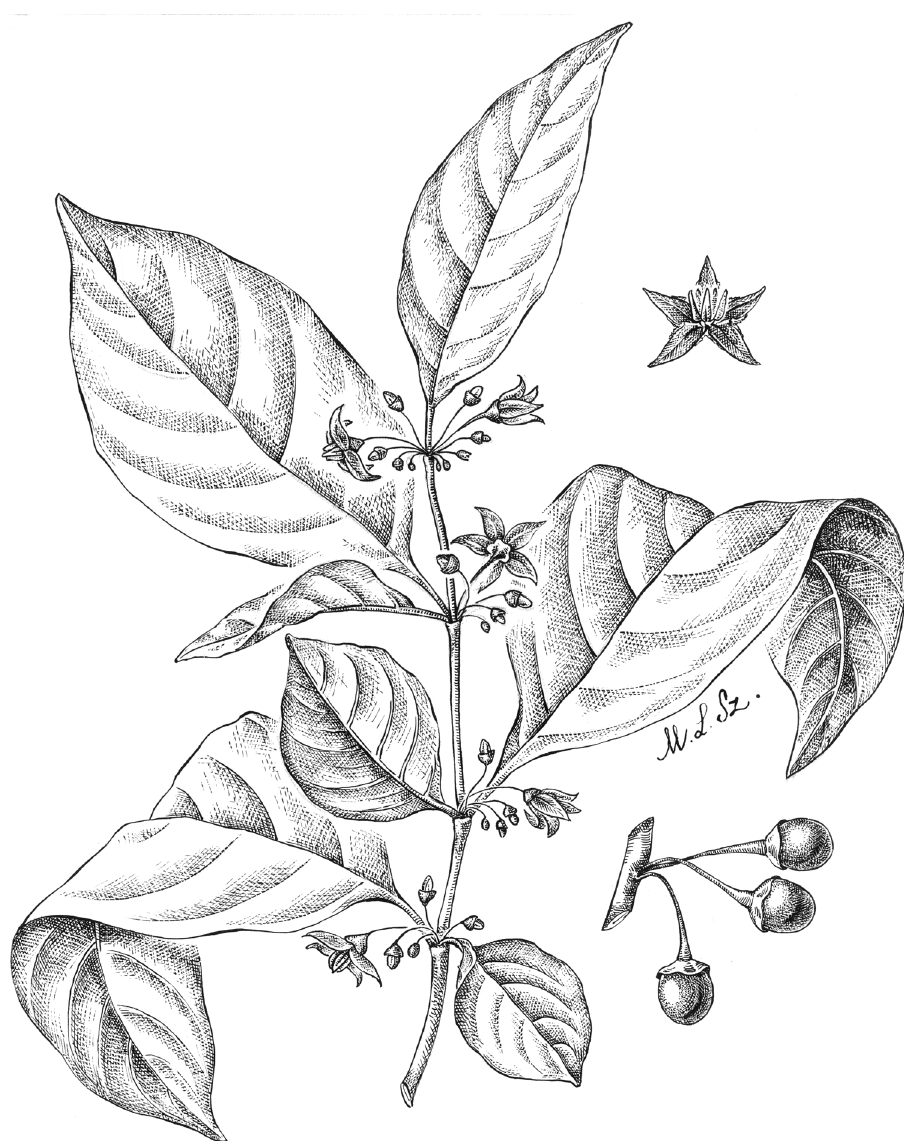
Figure 51. Lycianthes vitiensis (Seem.) A.R.Bean. Drawing by M.L. Szent-Ivany, first published in Symon (1985: fig. 24, as S. vitiense Seem.). Courtesy of the Board of the Botanic Gardens and State Herbarium (Adelaide, South Australia), reproduced with